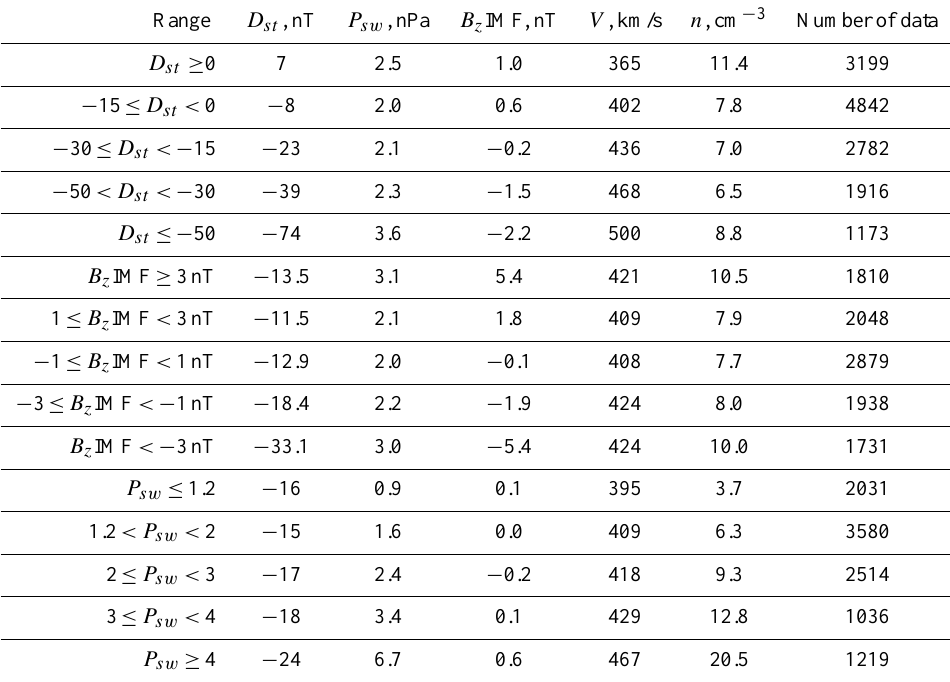
Table 1. D st and solar wind parameters inside each subset